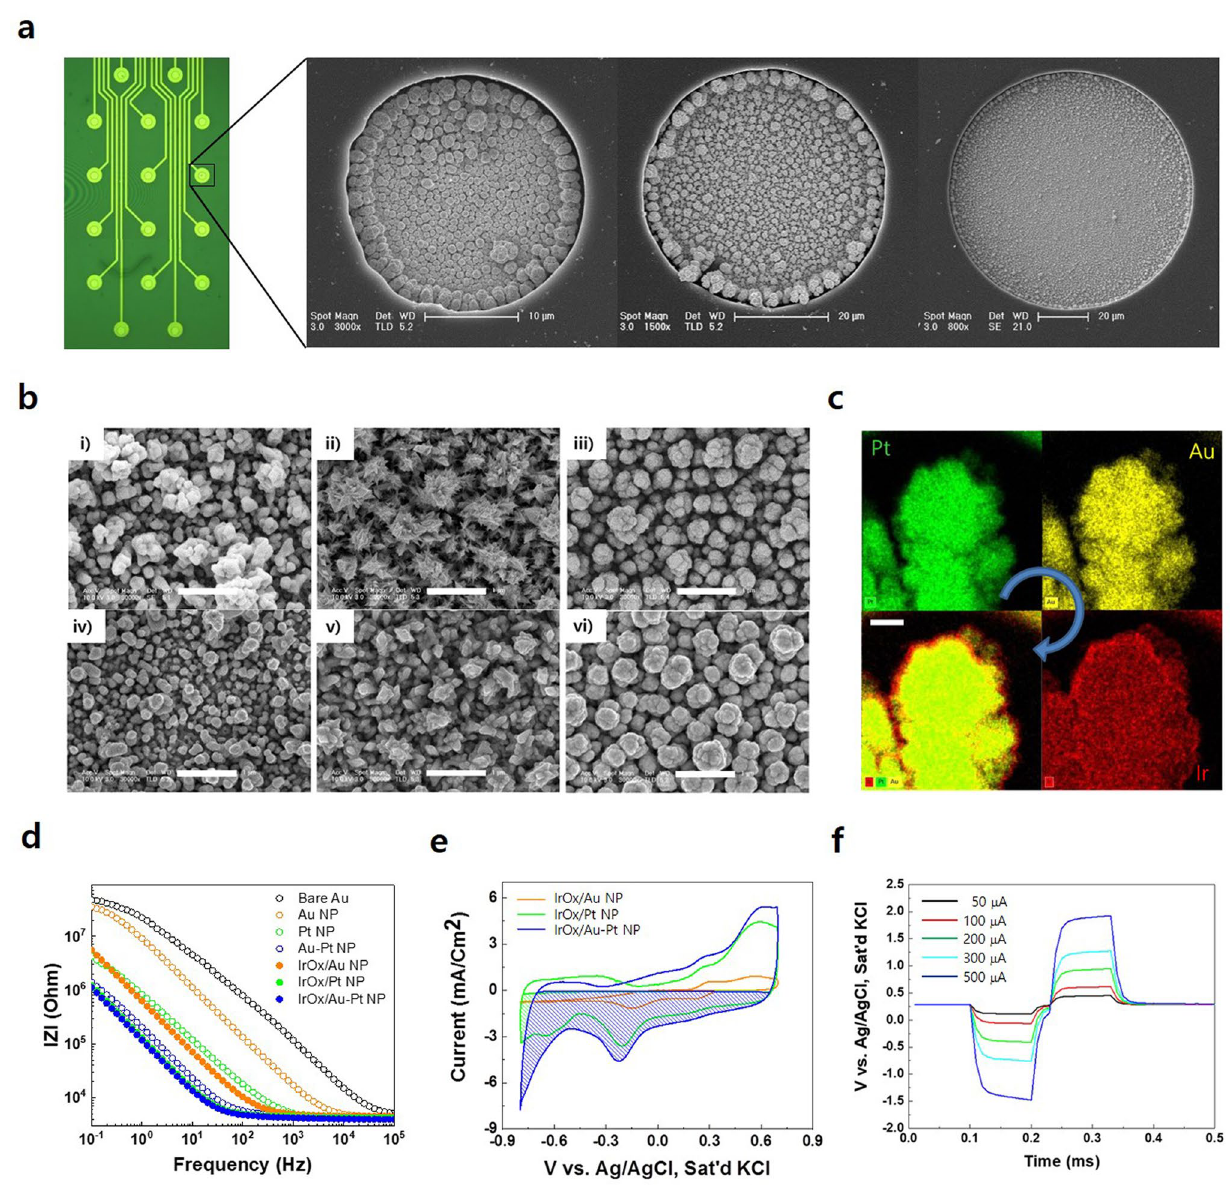
(iii) Au-Pt NPs, iv) IrOx/Au NPs, v) IrOx/Pt NPs, and vi) IrOx/Au-Pt NP-modified electrode. Scale bars denote 1 μm. ( c ) Cross-sectional TEM images of the Au-FEP interface with respect to plasma treatment time. Scale bar denotes 100 nm. ( d ) Electrochemical impedance spectroscopic results for the metallic NP- and IrOx/metallic NP-modified electrodes. ( e ) Cyclic voltammetry (CV) results for IrOx/metallic NP-modified electrodes. ( f ) Typical voltage transient of the IrOx/Au-Pt NP-modified electrode with an increasing biphasic current pulse amplitude (100 μs duration and 30 μs interpulse